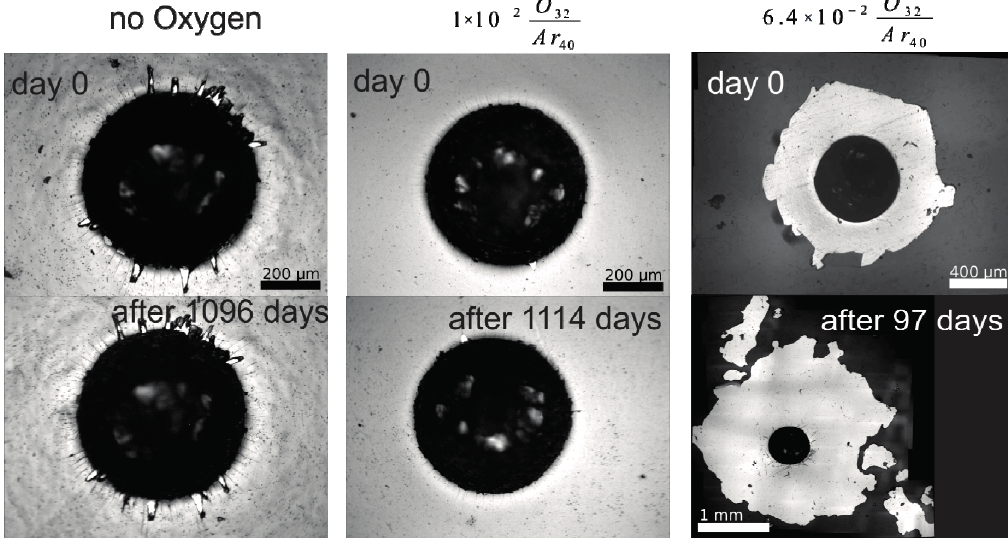
Figure 8. SCC (stress-corrosion cracking) test (delamination around indents) placed on DLC-coated reference samples with increasing oxygen interlayer